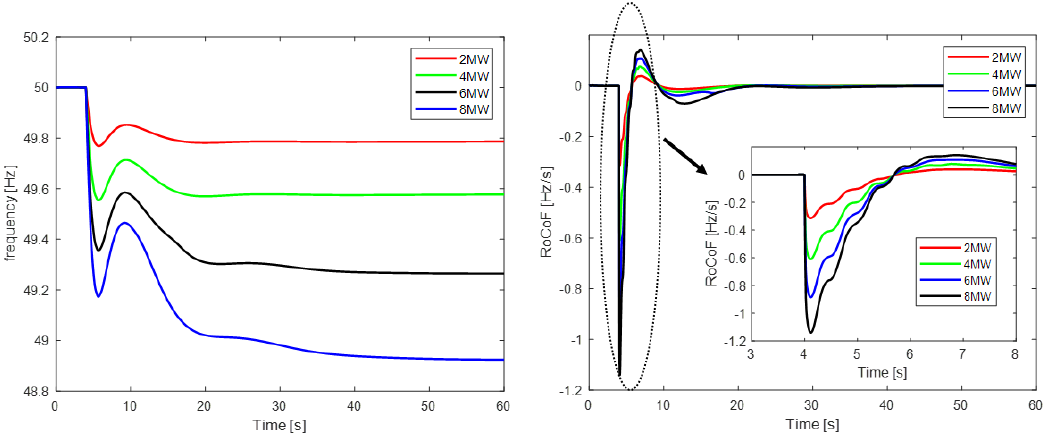
Figure 7. Load step-change frequency response and rate of change of frequency (RoCoF) for the best case of the reference scenario.